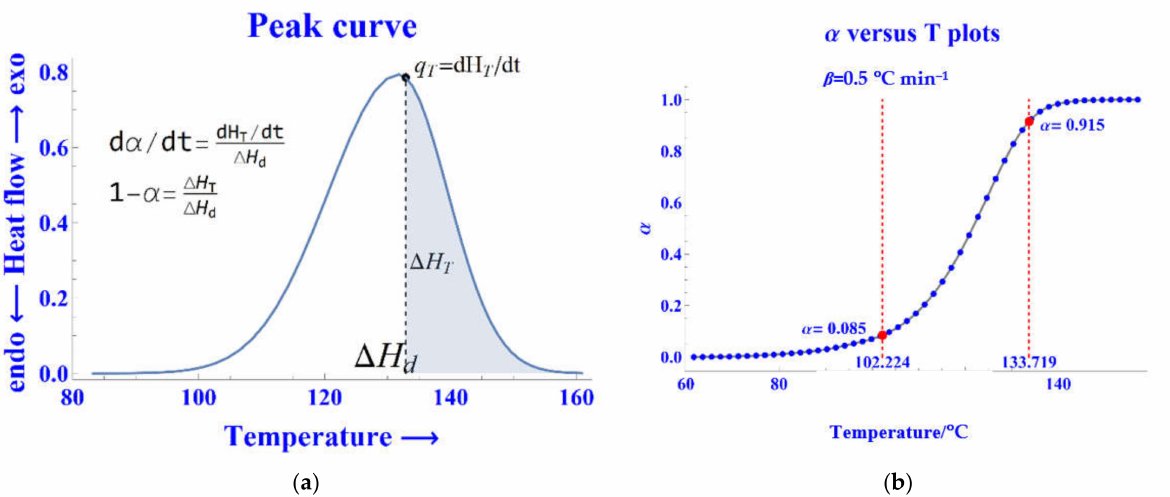
Figure 4. Procedures of B/D method. ( a ) Schematic diagram of related characteristic parameters; ( b ) calculated { T , α } record with equally spaced values between the temperature limits